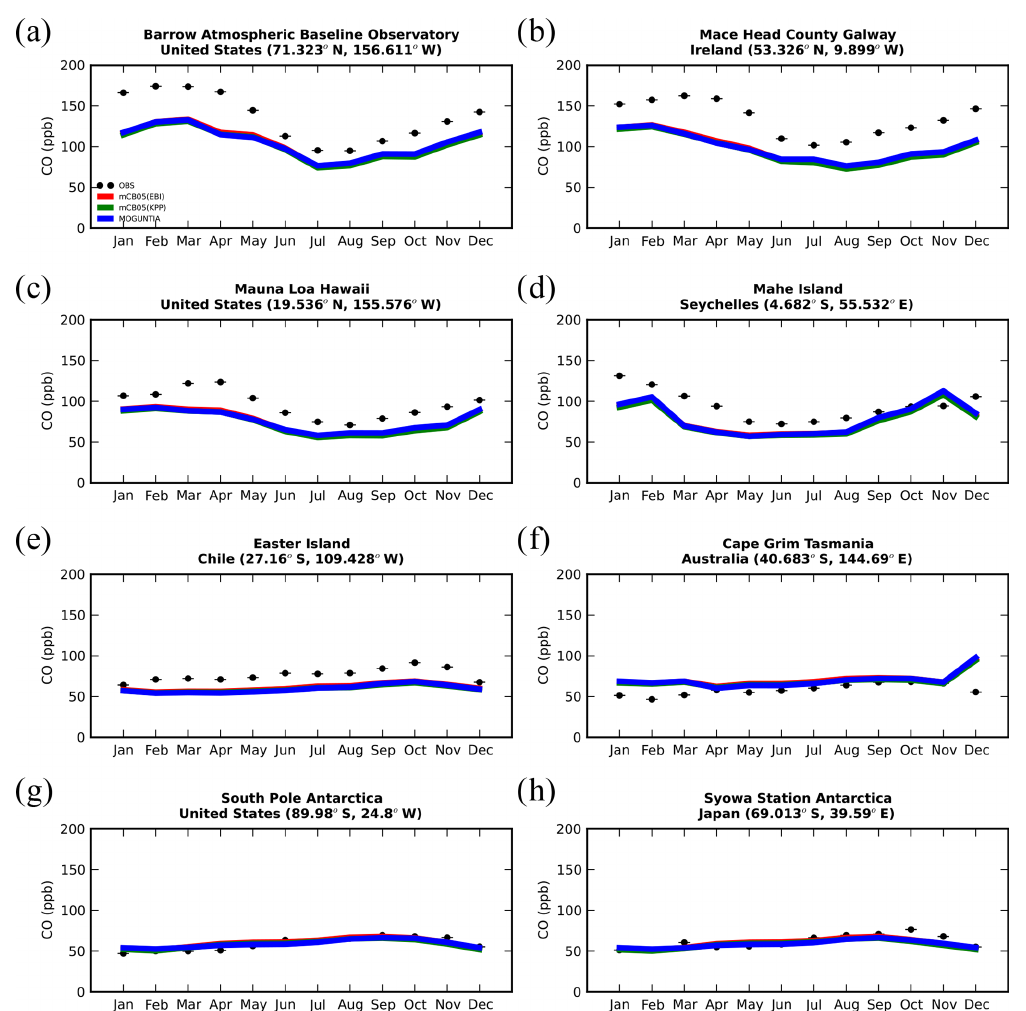
Figure 7. Monthly mean comparison of TM5-MP surface CO (ppb) against flask measurements (black line) for the two chemistry schemes, mCB05(KPP) (green line) and MOGUNTIA (blue line), using colocated model output for 2006 sampled at the measurement times; error bars indicate the standard deviation in the monthly means. For comparison, model results of mCB05 with the EBI solver (red line) are also